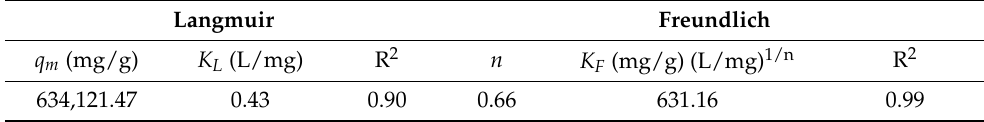
Table 1. Linear fitting parameters of CB adsorption isotherm equation. Langmuir